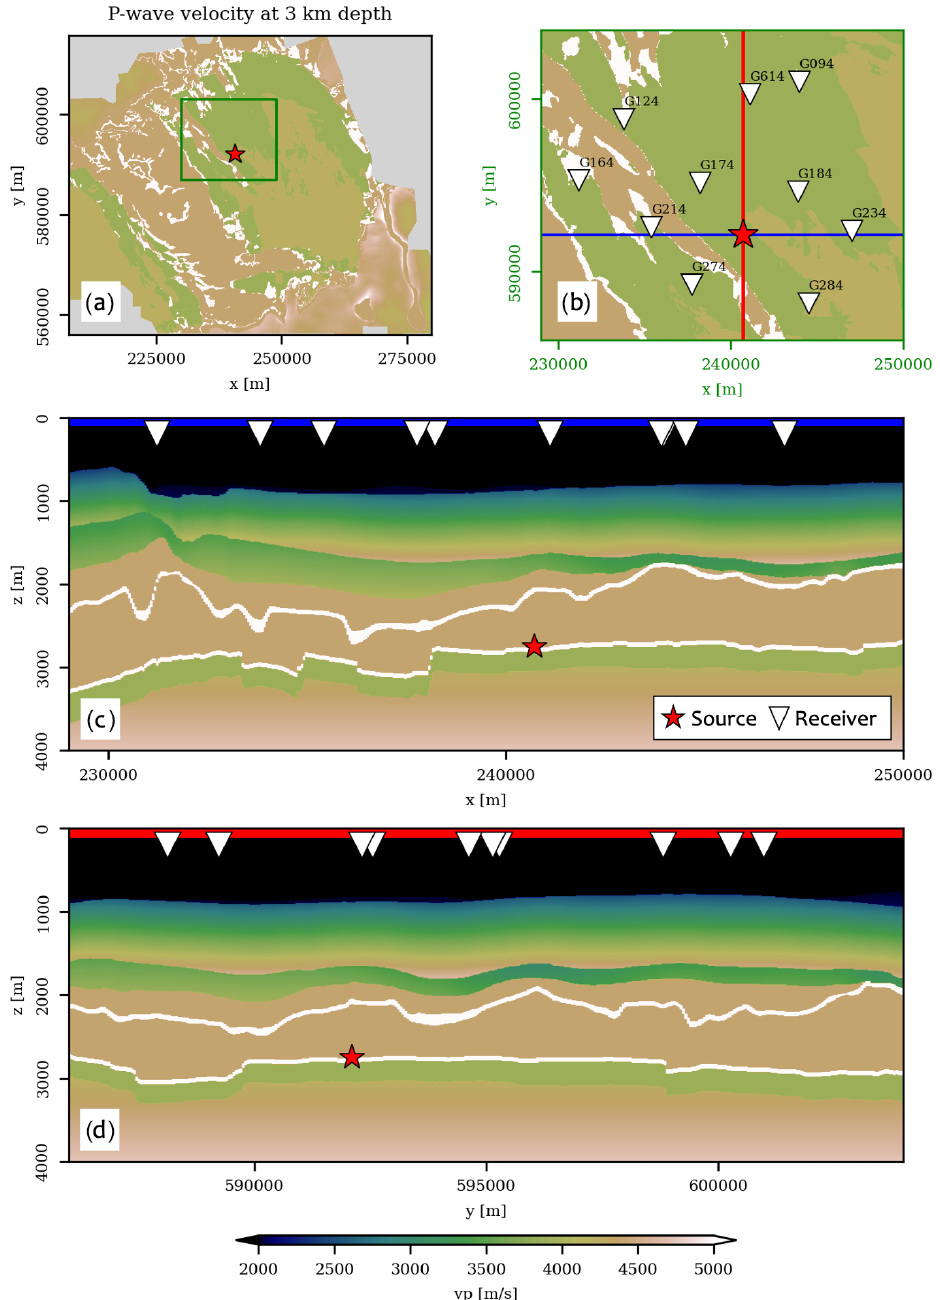
Figure 2. Scenario of an induced earthquake in the Groningen area. (a) Horizontal slice of the Groningen P-wave velocity model. (b) Zoom of the area indicated by the green rectangle in (a) . Inverted triangles indicate locations of KNMI stations (i.e., the x r ). (c) Vertical slice along the blue line in (b) . (d) Vertical slice along the red line in (b)